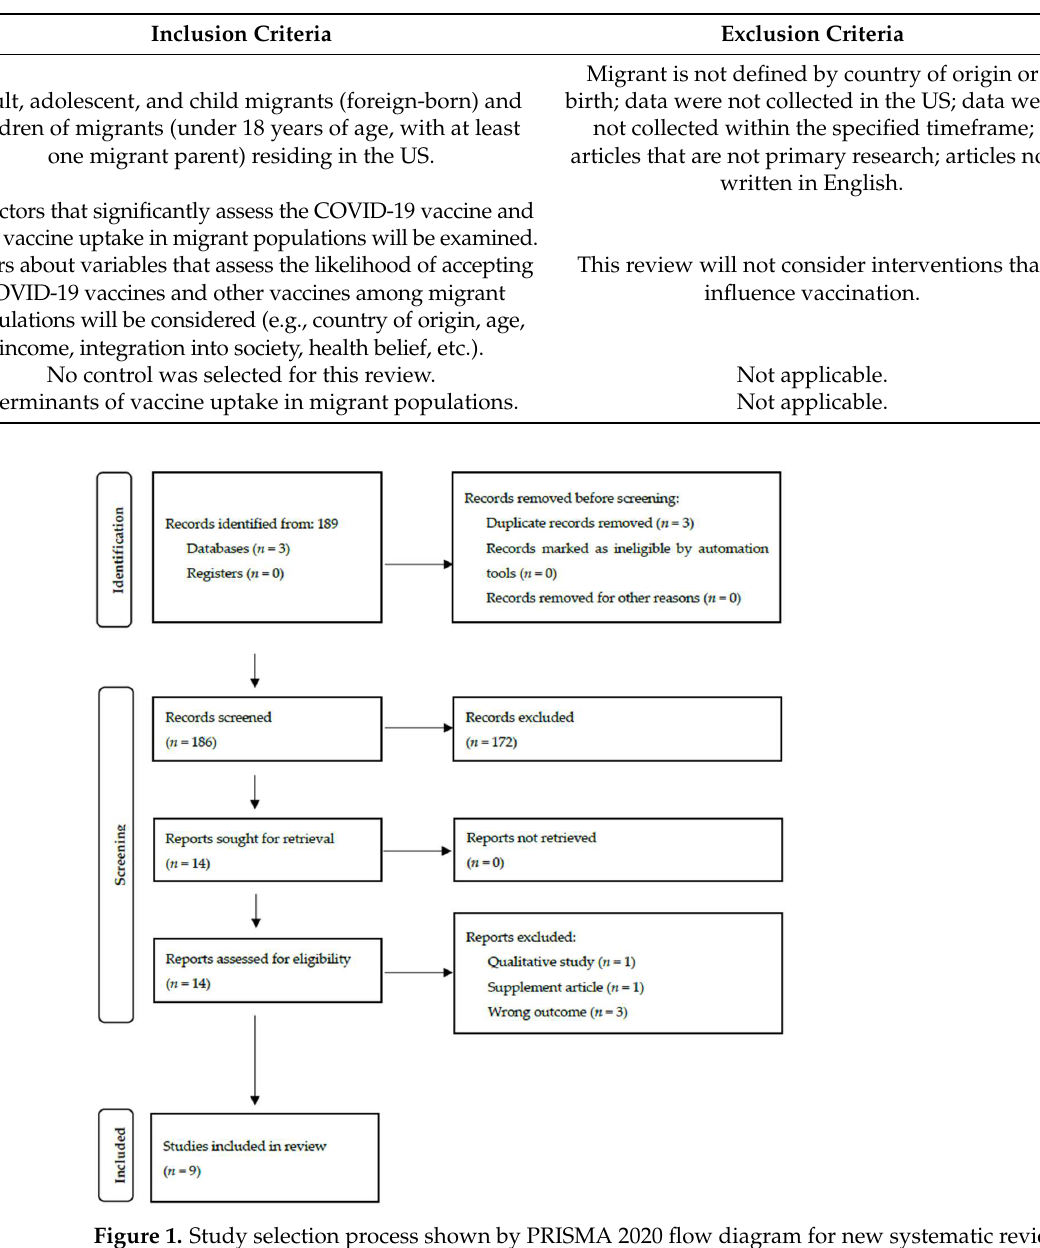
Table 1. Inclusion and exclusion criteria using PICOS framework.